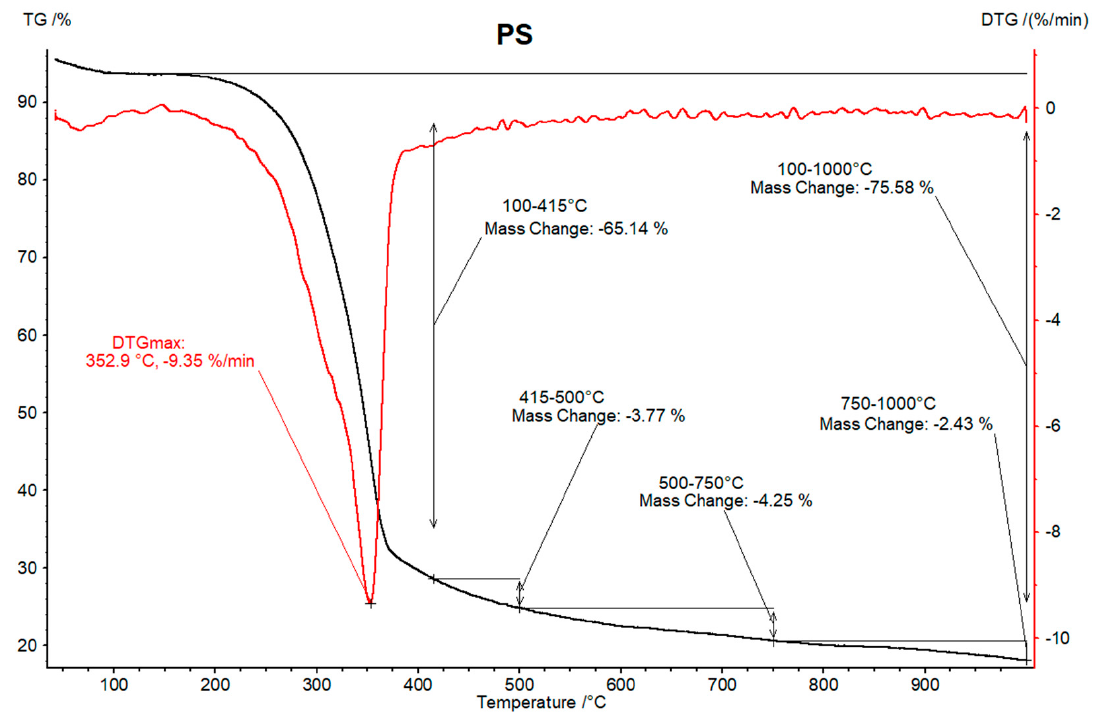
Figure A2. TG/DTG curves obtained for pine sawdust.